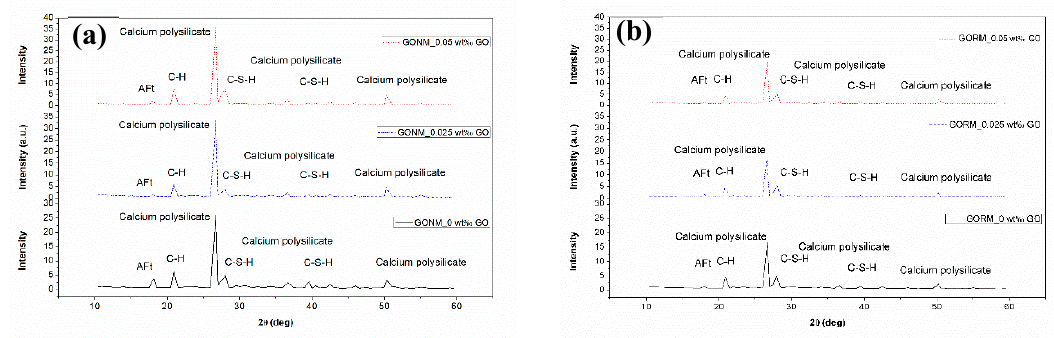
Figure 7. XRD crystalline analysis: ( a ) GONM without GO and with w GO = 0.025 wt‰ and w GO = 0.05 wt‰; ( b ) GORM without GO and with w GO = 0.025 wt‰ and w GO = 0.05 wt‰.